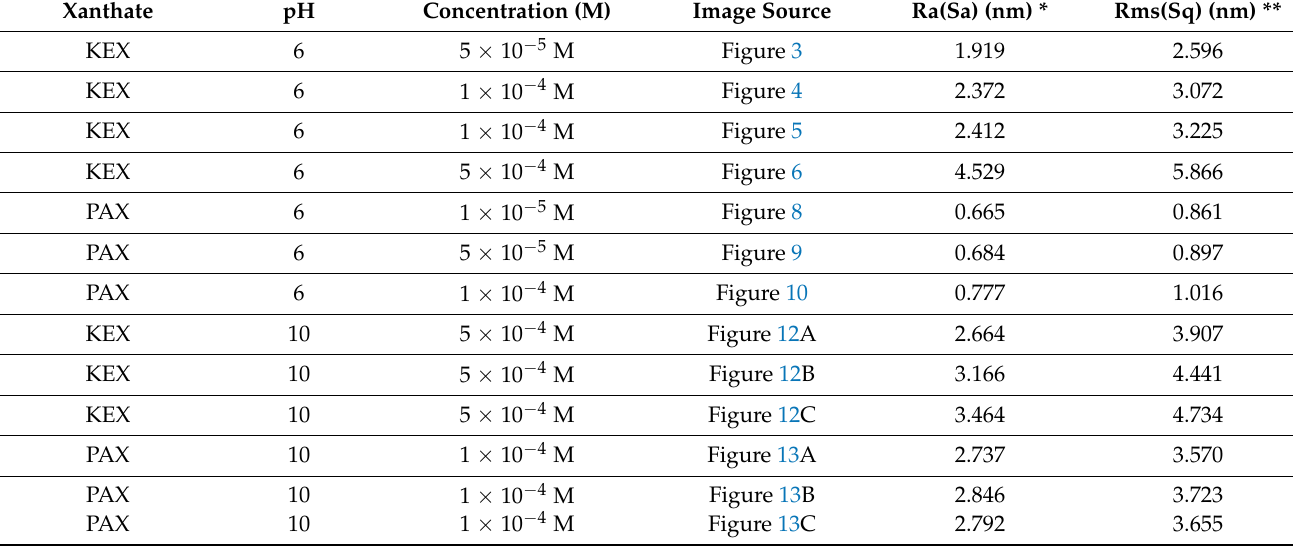
Table 1. Roughness analysis of the AFM images of a bornite surface in xanthate